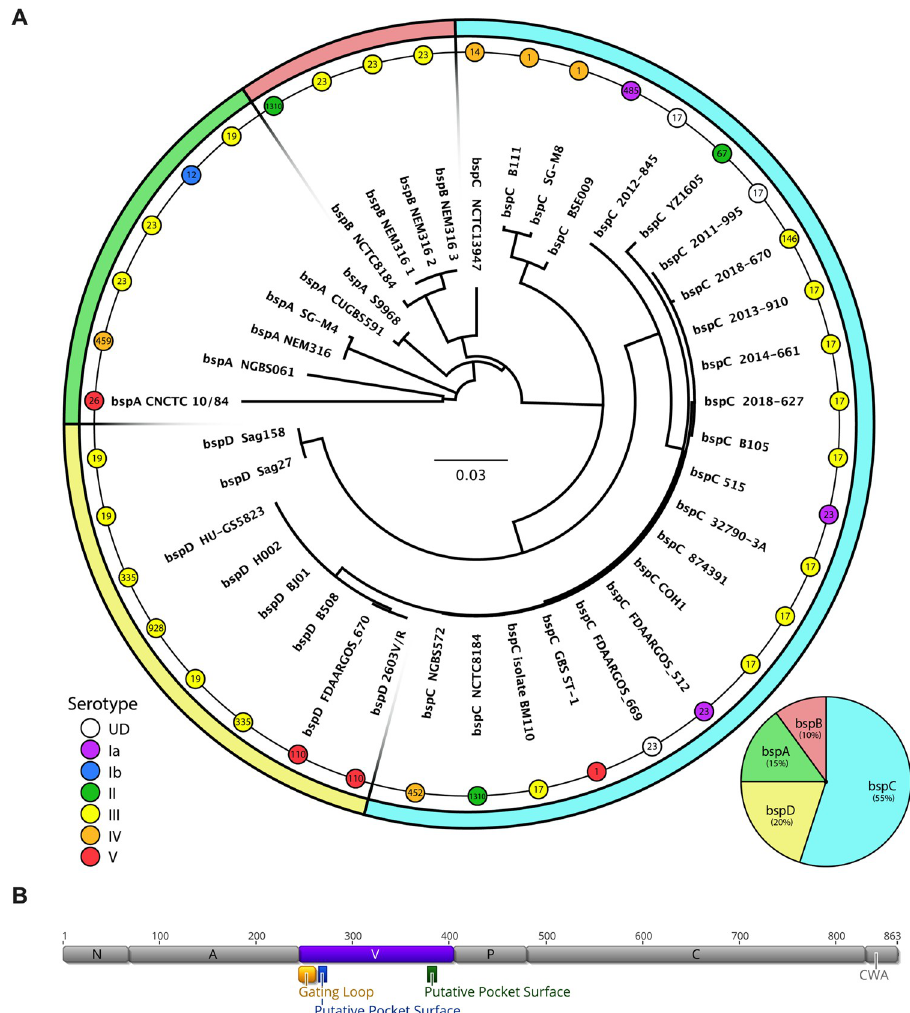
Fig 1. Bsp Distribution and Conservation. (A) The amino acid sequences listed in S1B Fig were used to form a neighbor-joining phylogenetic tree calculated by a Blosum80 cost matrix and Jukes-Cantor genetic distance model. The scale bar in the center indicates the distance representing 0.03 substitutions per site. Serotype of each strain is indicated by a colored node, while sequence type is indicated by a number within each node. This tree is overlaid on a pie chart which shows the distribution of each bsp homolog (also shown in the bottom right). (B) The gene structure for COH1 bspC is shown, with specific domains and relevant regions within the V-domain